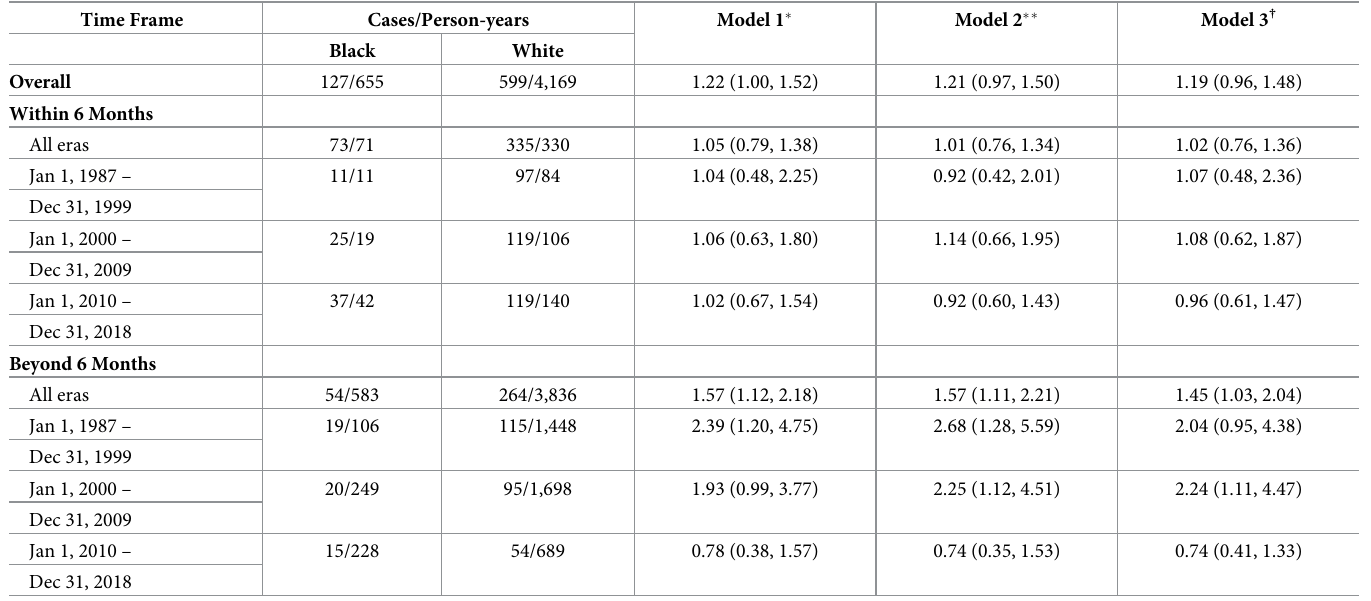
Model 2: Adjusted for all covariates in Model 1 and education level and insurance type † Model 3: Adjusted for all covariates in Model 2 and setting of post-transplant